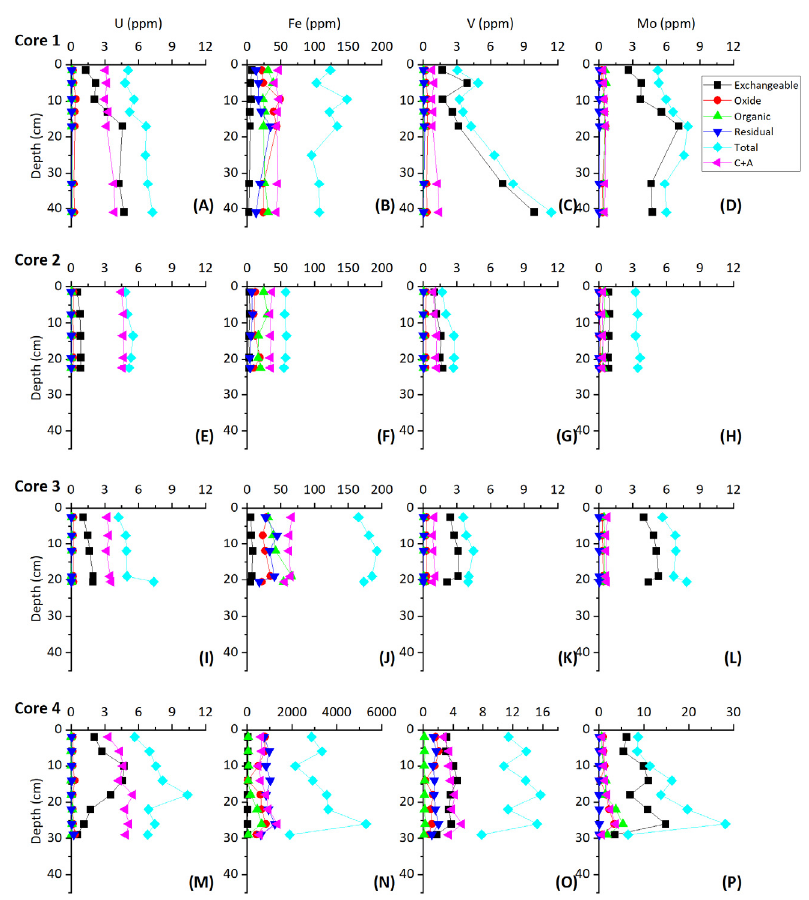
Figure 6. Sequential extraction results for the shallow sediment core samples.